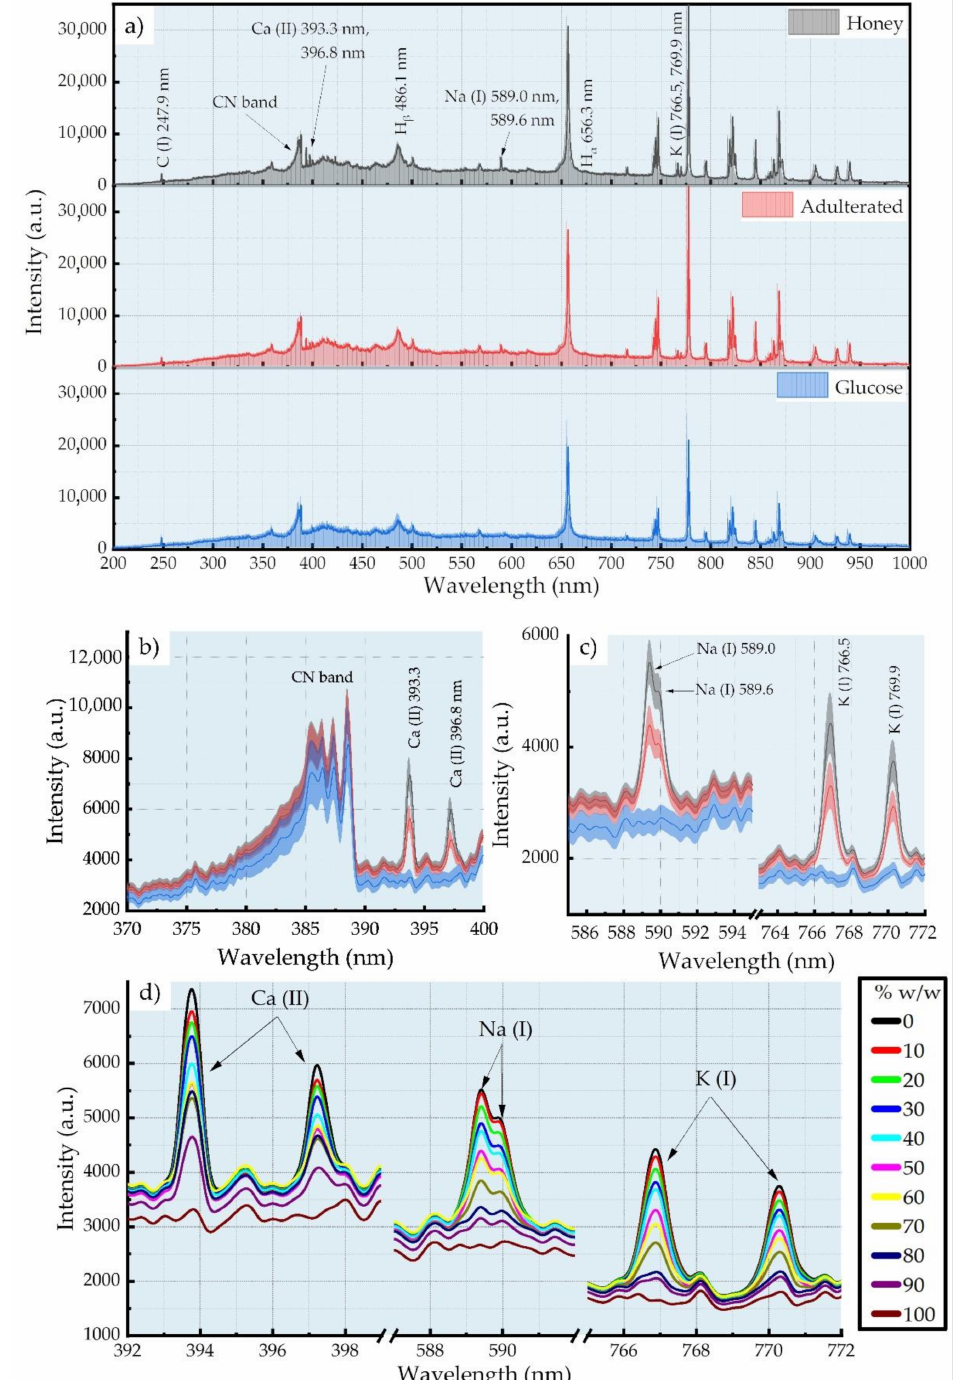
Figure 1. ( a ) LIBS spectra of honey, adulterated honey (50% w / w ), and glucose syrup samples. ( b ) CN band and Ca (II) spectral lines, ( c ) Na (I) and K (I) spectral lines in a honey, an adulterated honey, and a glucose syrup sample. ( d ) Ca (II), Na (I), and K (I) spectral lines of different % adulterated honey